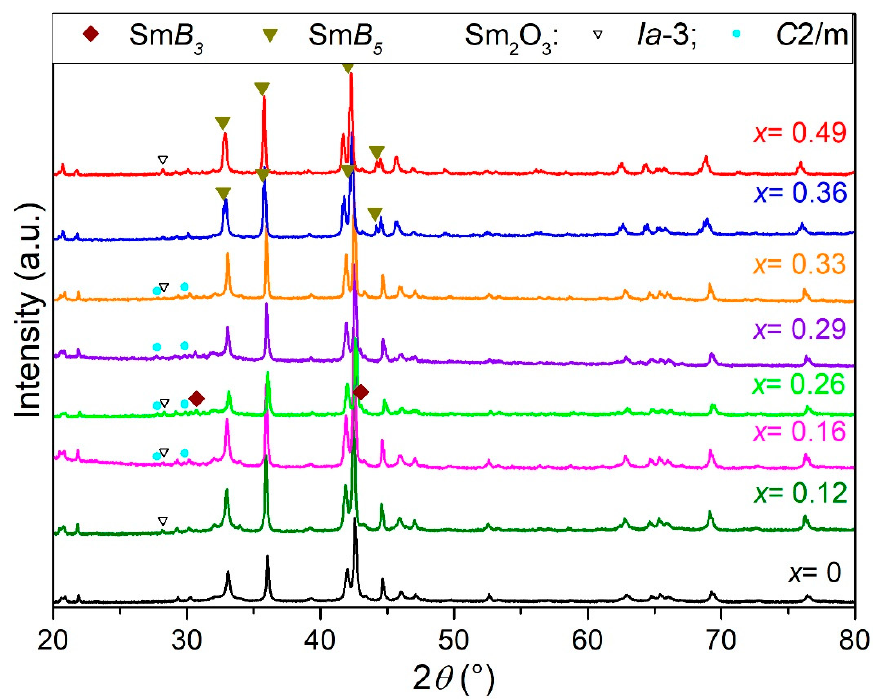
ff raction patterns of Sm = 0, 0.12, 0.16, 0.26, Figure 1. Evolution of the diffraction patterns of Sm 2 Mn x Ni 7 − x as a function of x = 0, 0.12, 0.16, 0.26, Figure 1. Evolution of the di 2 Mn x Ni 7 − x as a function of x 0.29, 0.33, 0.36, 0.49. One can notice the presence of SmB 5 and SmB 3 secondary phases (B = Mn,